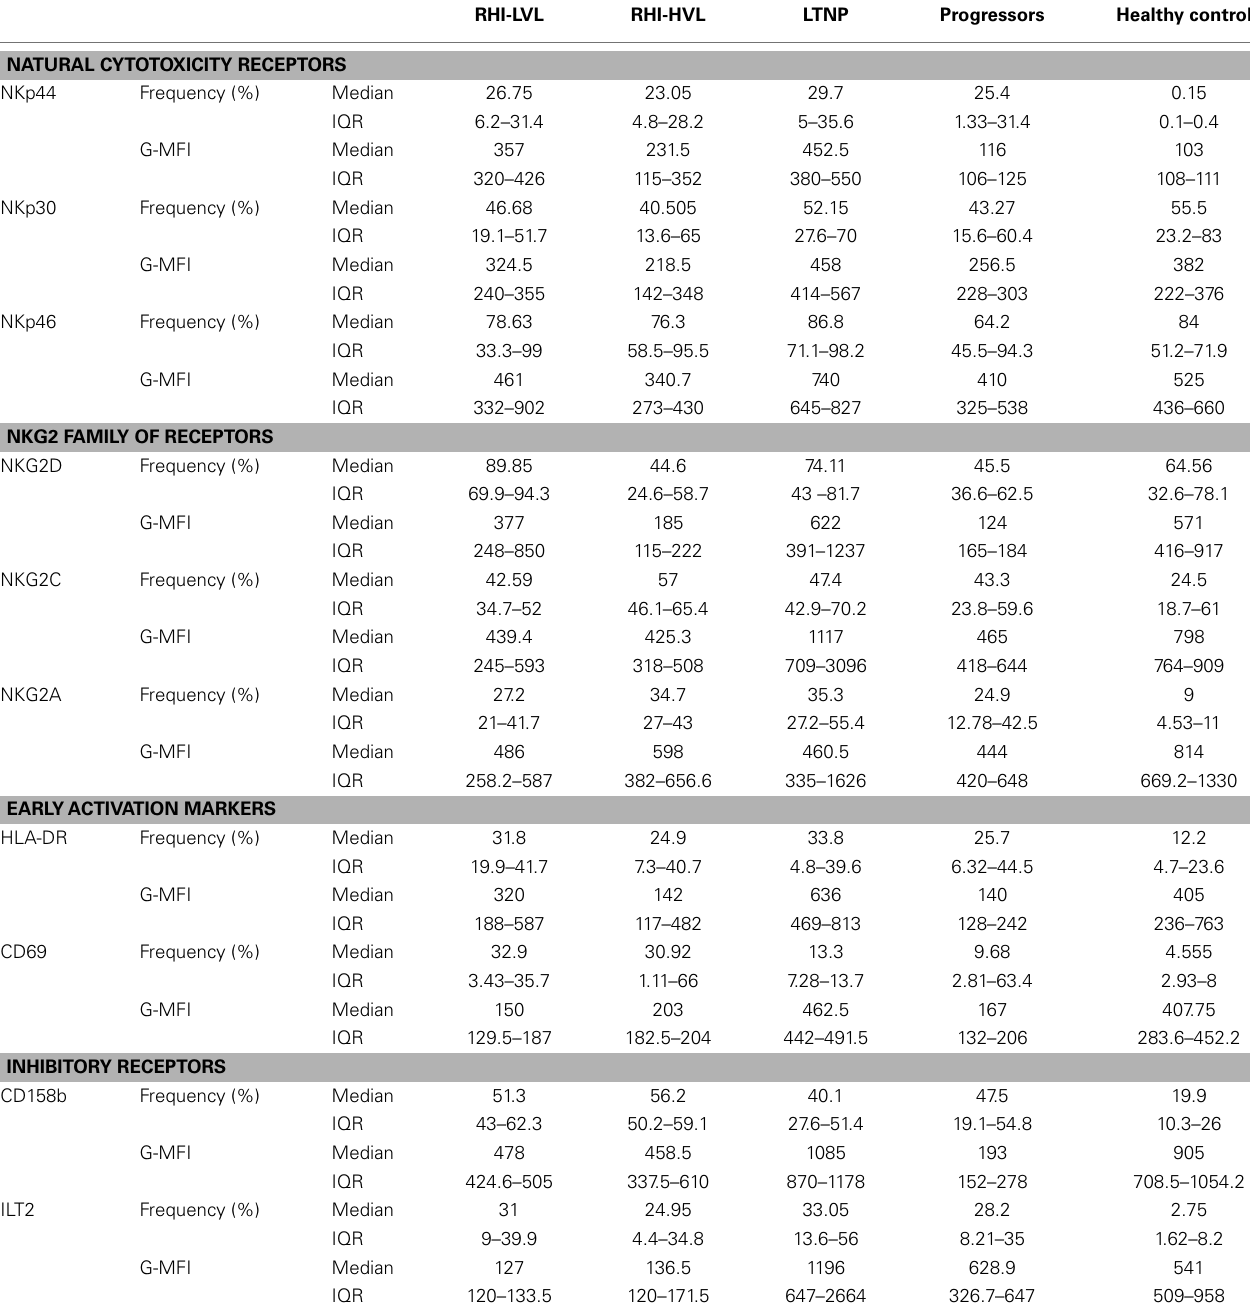
Table 3 | Frequency and expression level (G-MFI) of NK cell receptors